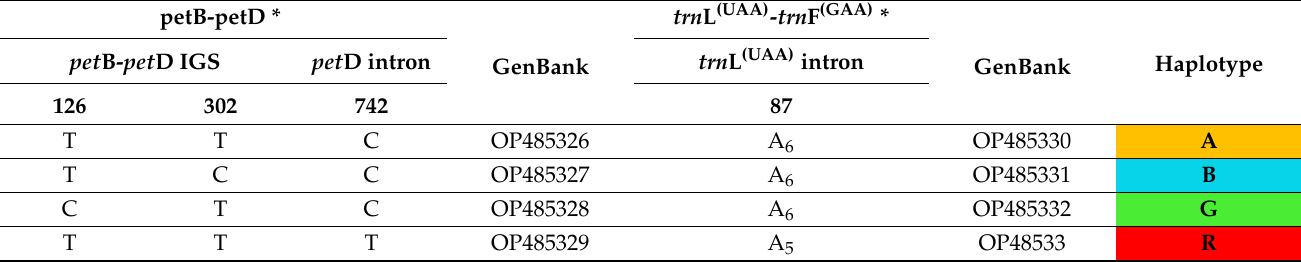
* The base position corresponds to the haplotype A sequence as